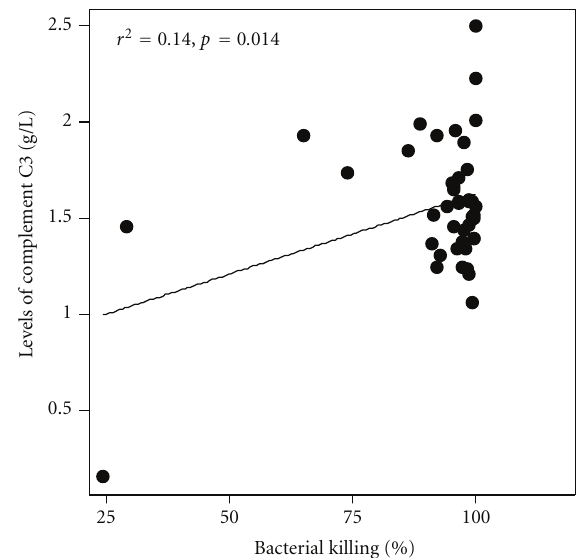
Figure 2: Correlation between the levels of serum complement C3 (g/L) from arsenicosis patients with bactericidal activity (bacterial killing, %) on Escherichia coli DH5 α cells. The figure shows bacterial killing decreased as the levels of C3 decreased in arsenic toxicity, giving a direct correlation ( P = 0 .